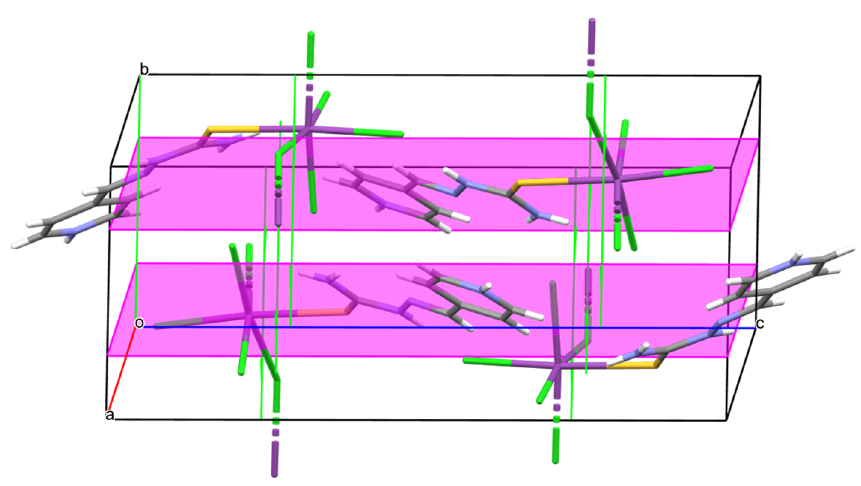
Figure 7. Symmetric elements of the [Bi(HQ)(Cl) 4 ] n crystal shown along the axis C (green axes: screw axes 2 1 and purple planes: glides planes; the dotted lines between some of the Cl1 and Bi1 represent the relative longer distance, 2.861(3) Å, and weaker interaction between them).